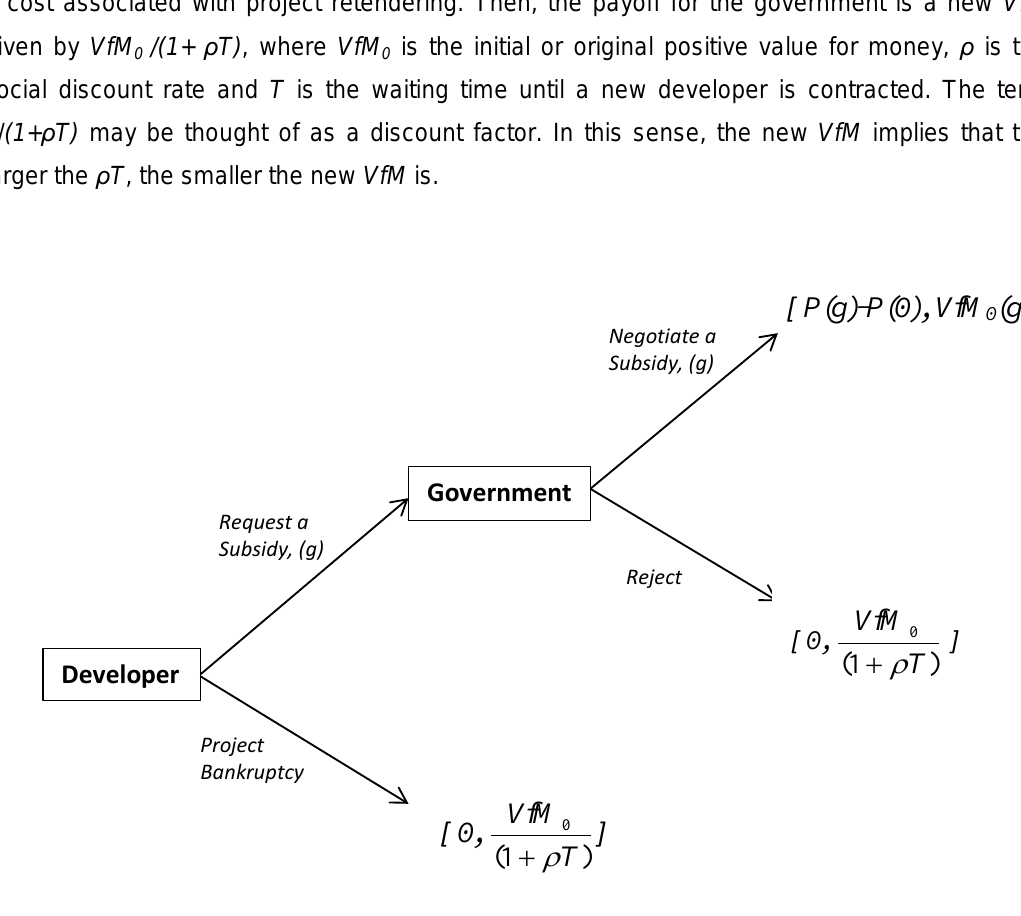
Figure 1. Renegotiation Game’s Equilibrium Path. Source: own